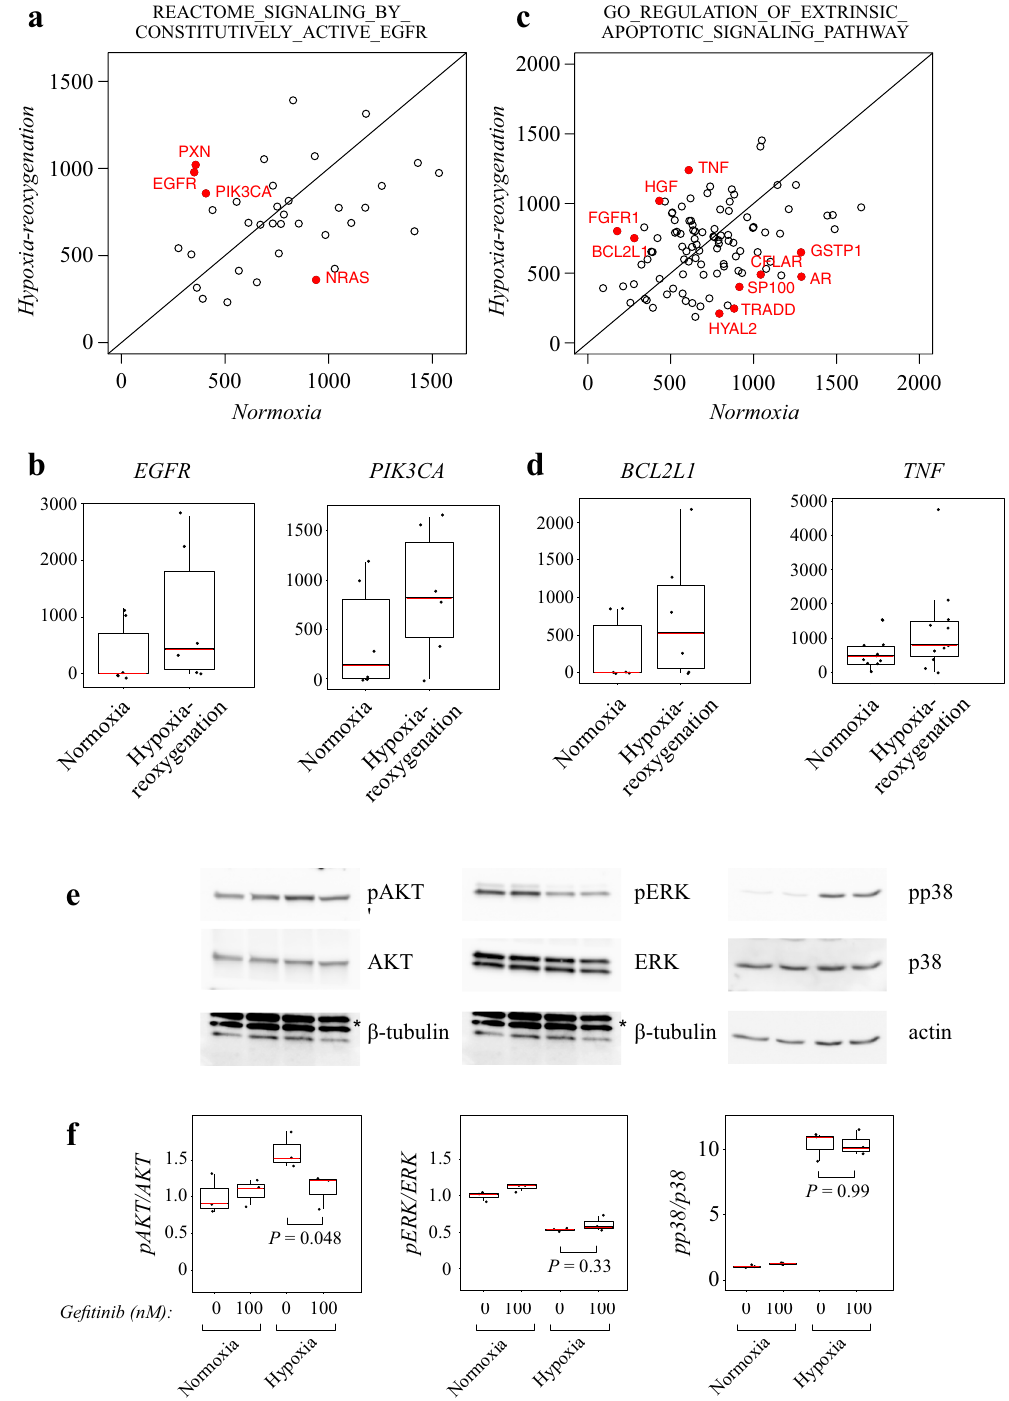
Figure 5. Pathways involved in hypoxia-reoxygenation response and EGFR-mediated signal transduction. ( a ) Scatterplot of mean reads of shRNAs (normoxia vs. hypoxia-reoxygenation) against genes in the pathway REACTOME_SIGNALING_BY_CONSTITUTIVELY_ACTIVE_EGFR. Significantly differentially expressed genes are depicted with red dots and labels. ( b ) Boxplots of reads for shRNAs against EGFR and PIK3CA . ( c ) Scatterplot of mean reads of shRNAs against genes in the pathway GO_REGULATION_OF_EXTRINSIC_ APOPTOTIC_SIGNALING_PATHWAY. Significantly differentially expressed genes are depicted with red dots and labels. ( d ) Boxplots of reads for shRNAs against BCL2L1 and TNF . ( e ) Western analysis of phosphorylated and total AKT, ERK and p38 in HL-1 cells treated overnight with 0 or 100 nM of gefitinib and exposed to hypoxia for 3 h. β-Tubulin (the lowest band) or actin were used as loading controls, * = non-specific bands. ( f ) Densitometric analysis of phosphorylated AKT, ERK and p38 against total protein levels (arbitrary units). N = 3 biological replicates. One-way ANOVA followed by paired T-test was used for statistical